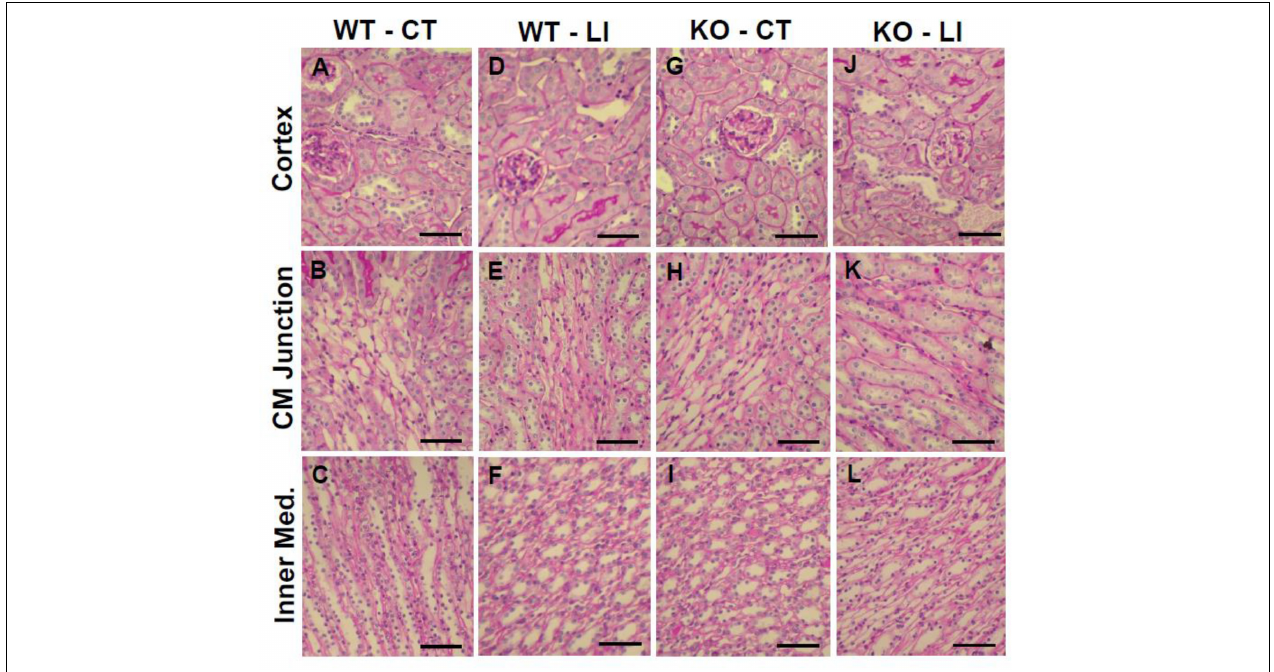
FIGURE 10 | Representative profiles of morphological appearance of kidneys of WT and P2Y 2 KO mice fed control (CT) or lithium-added (LI) diets for 5 months. Formalin-fixed and paraffin-embedded kidney samples were sectioned and stained with PAS (periodic acid Schiff reagent). (A–C) WT control mice; (D–F) WT lithium mice; (G–I) KO control mice; and (J–L) KO lithium mice. CM Junction – cortico-medullary junction. Bar represents 50 µ